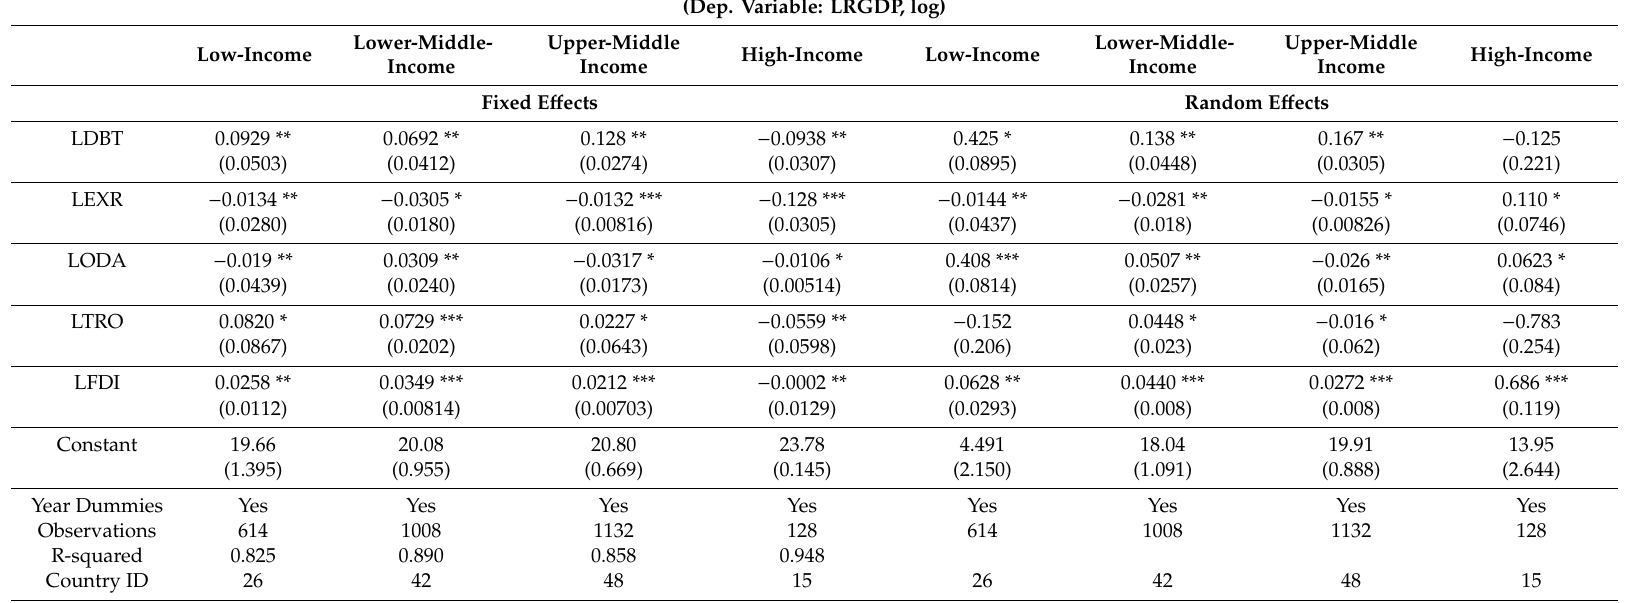
Table 6. Fixed- and random-e ff ects estimates for comparative analysis across the four World Bank income